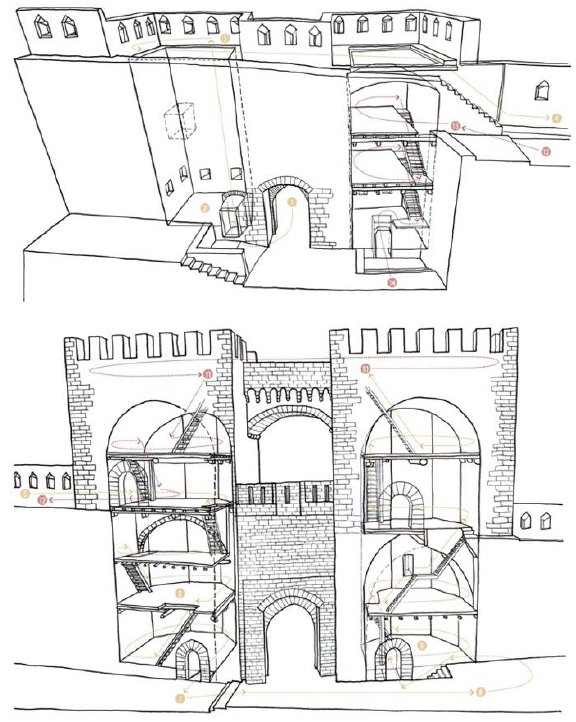
Figure 14. At the top, the touring patterns through the inside of the Portal de la Nevera and, at the bottom, through the Portal de Sant Miquel (Source: S. Portela,